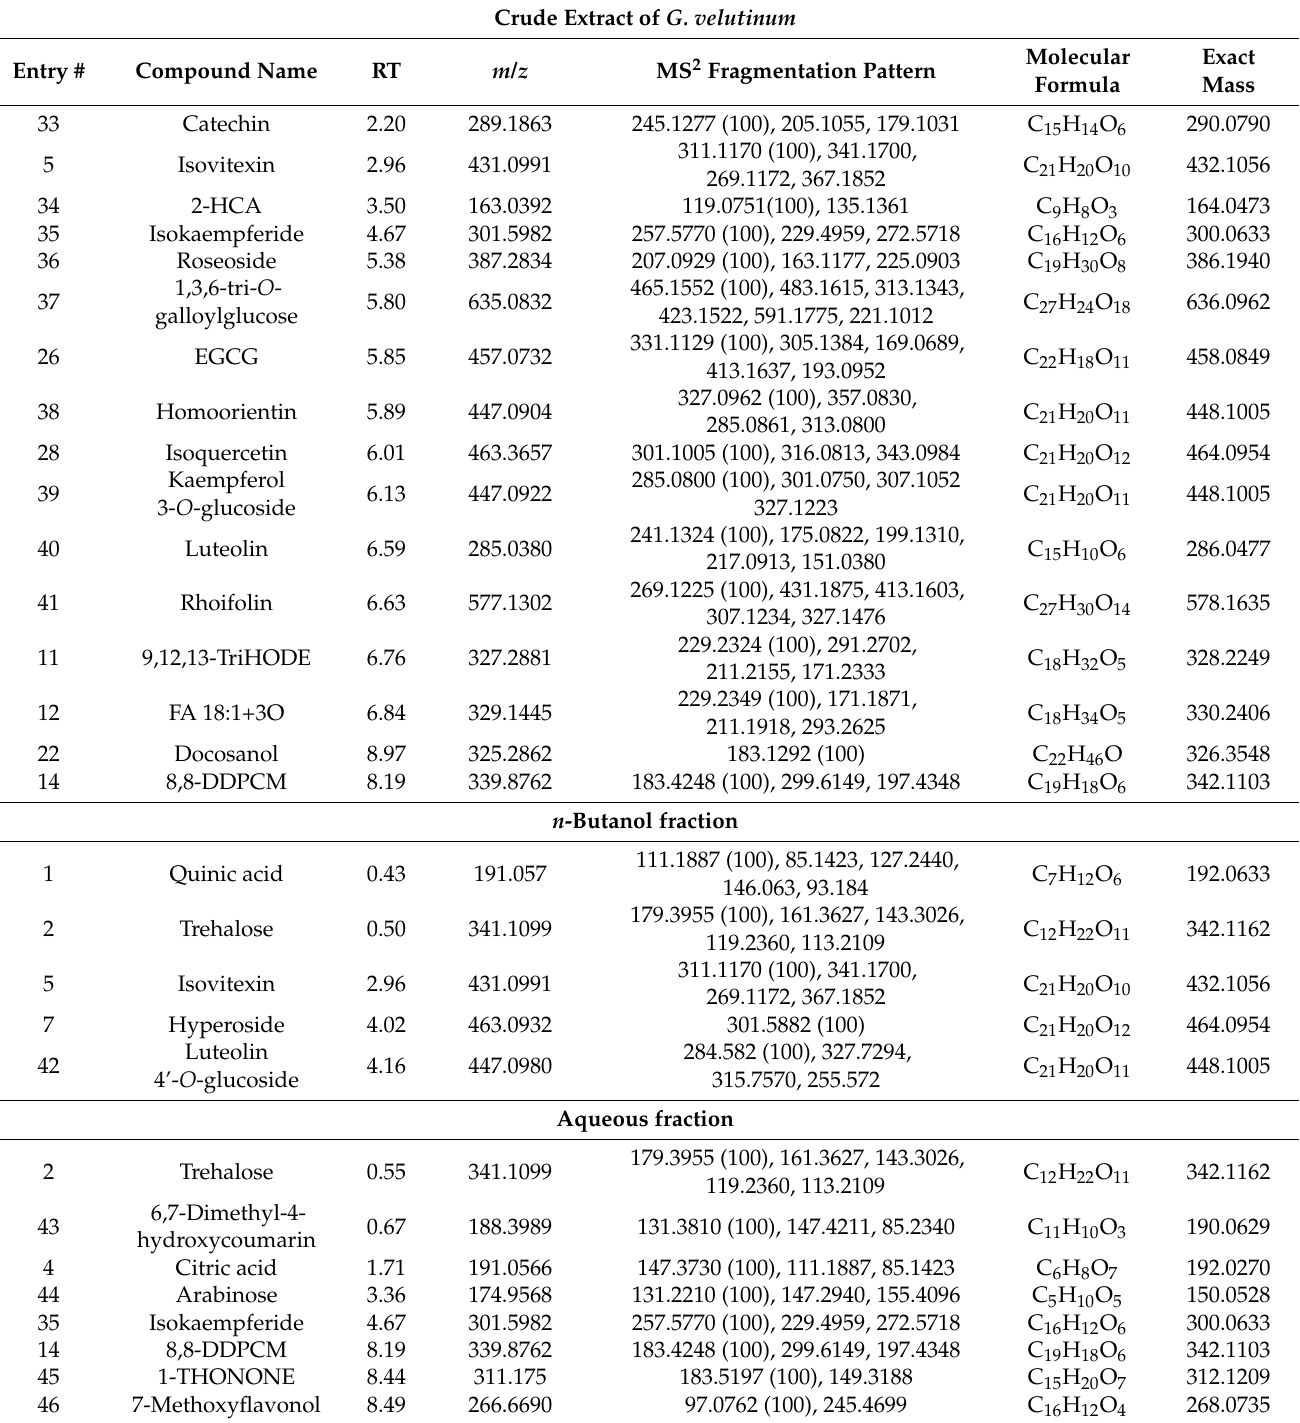
Table 3. Cont. Crude Extract of G.